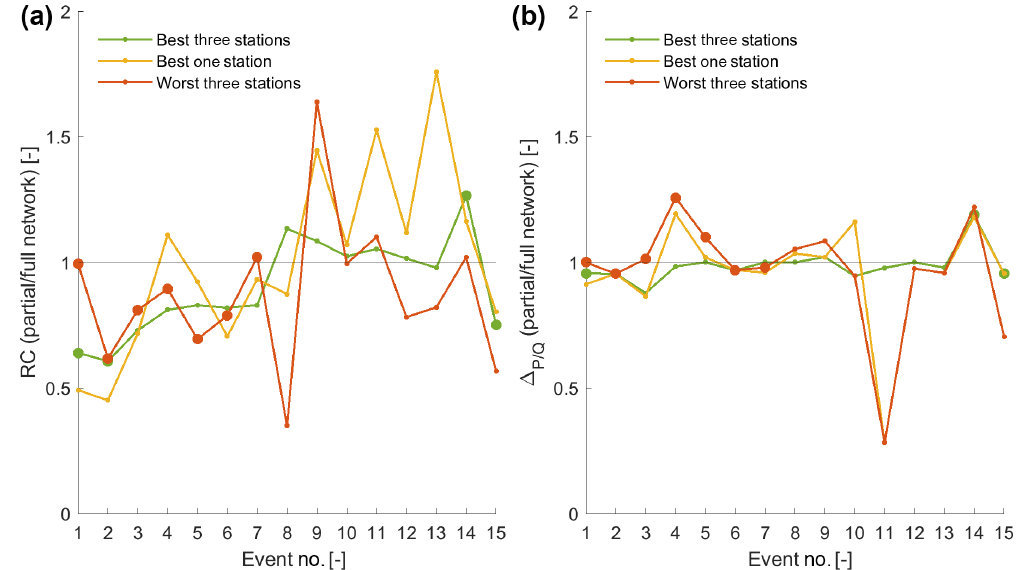
Figure 12. Comparison of streamflow response metrics ratios between a partial network (best three-station, best one-station and worst three- station networks) and the full rain gauge network, using the RC (a) and lag time (cid:49) P/Q (b) . The data set is subset no. 4 in Table 2. Larger dots highlight events where events where only two of three stations were operational (see Sect. 4.1.1). The lines connect the events to improve readability.